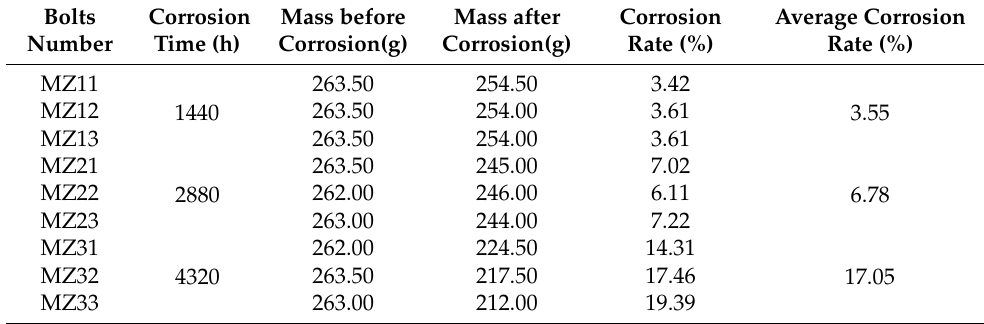
Figure 11. Specimens after removing corrosion product. ( a ) Steel plate; ( b ) High-strength bolts. Table 3. Corrosion rate of high-strength bolts.